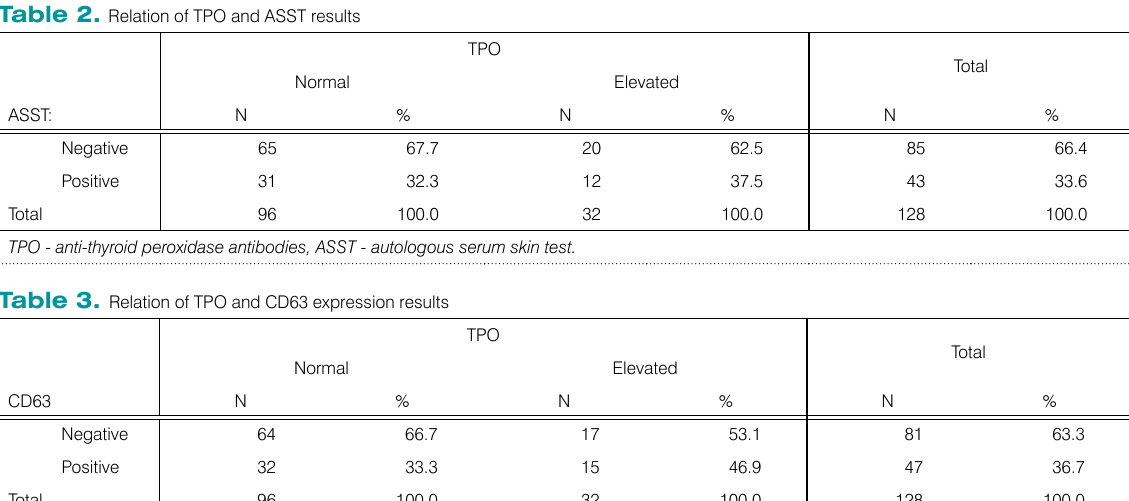
Table 2. Relation of TPO and ASST results